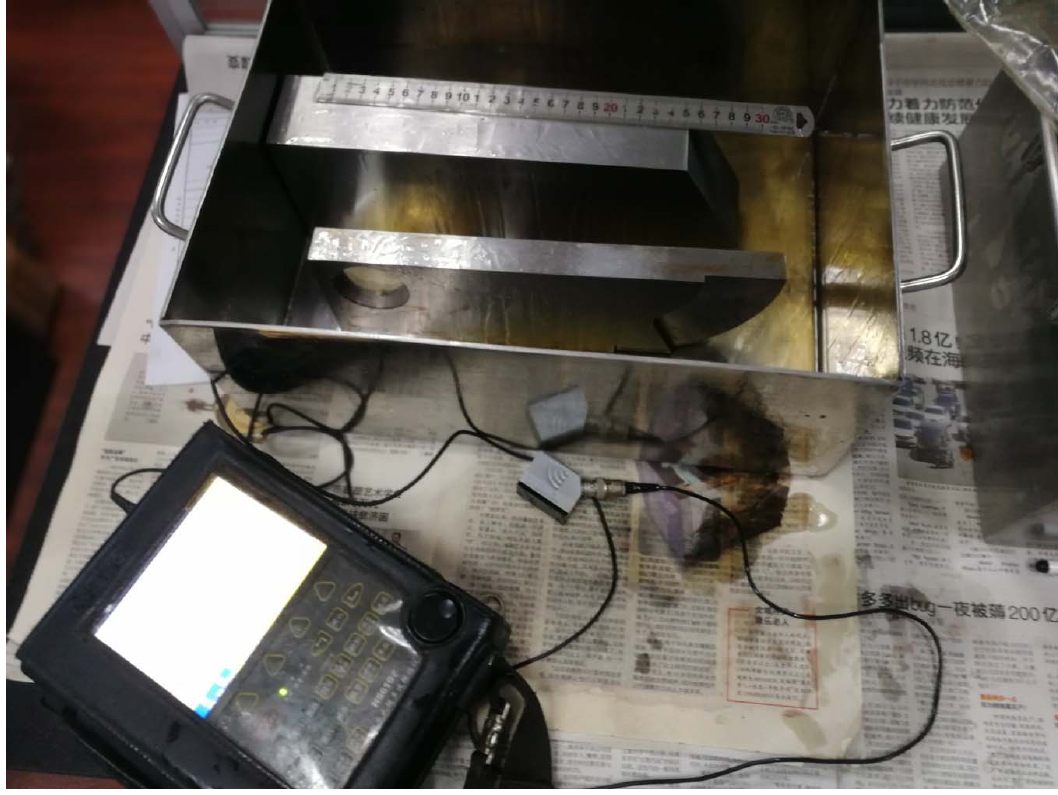
Figure 5. The experimental environment.